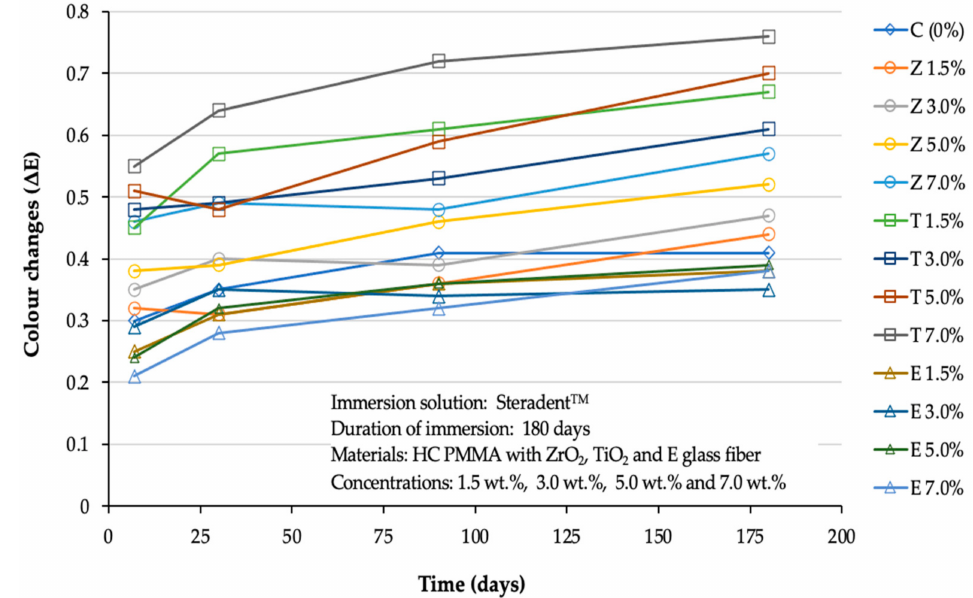
Figure 1. Line graph showing the cubic trend of the studied materials across the different time points in Steradent™